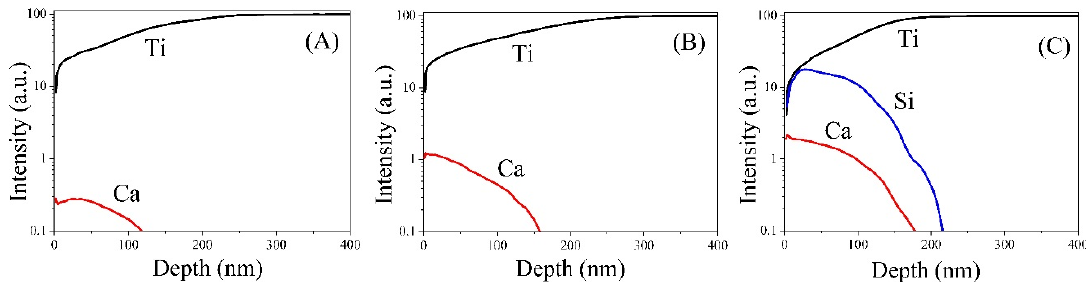
Figure 4. Secondary neutral mass spectrometry (SNMS) depth profiles of ( A ) 5Ca, ( B ) 10Ca and ( C ) 5CaSi ion ‐ implanted surfaces.